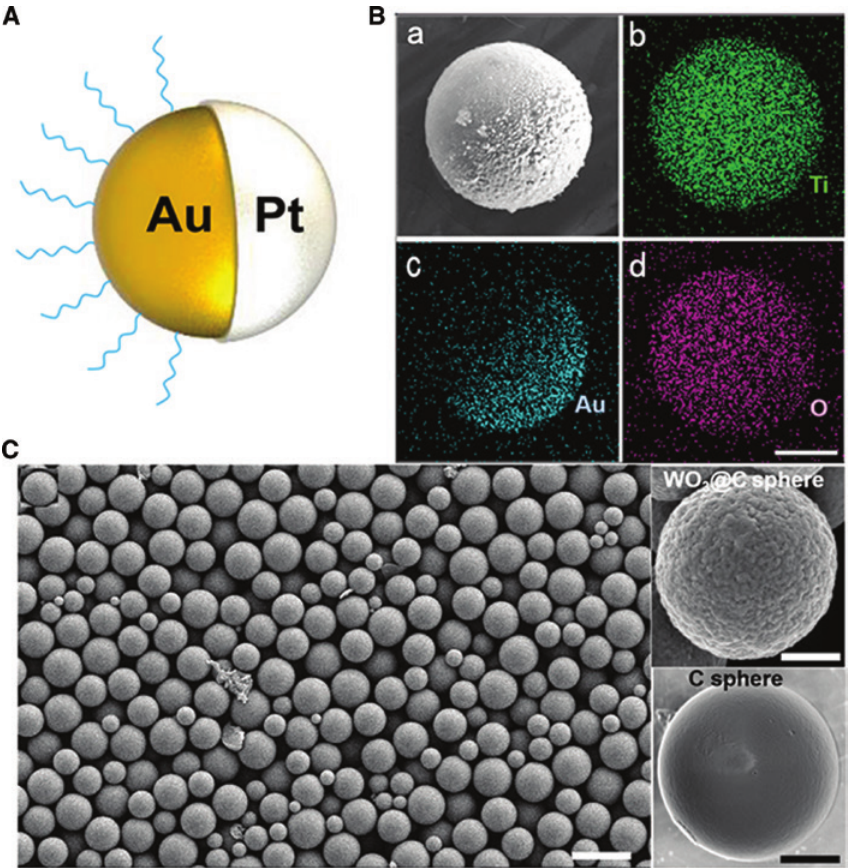
Figure 7: Structure of the microspheres employed in light-driven micro/nanomotors. (A) Schematic of the microsphere Au/Pt micromotor [103]. Copyright 2015, American Chemical Society. (B) SEM image and energy dispersive X-ray images for Ti, Au and O elements for the Au/TiO